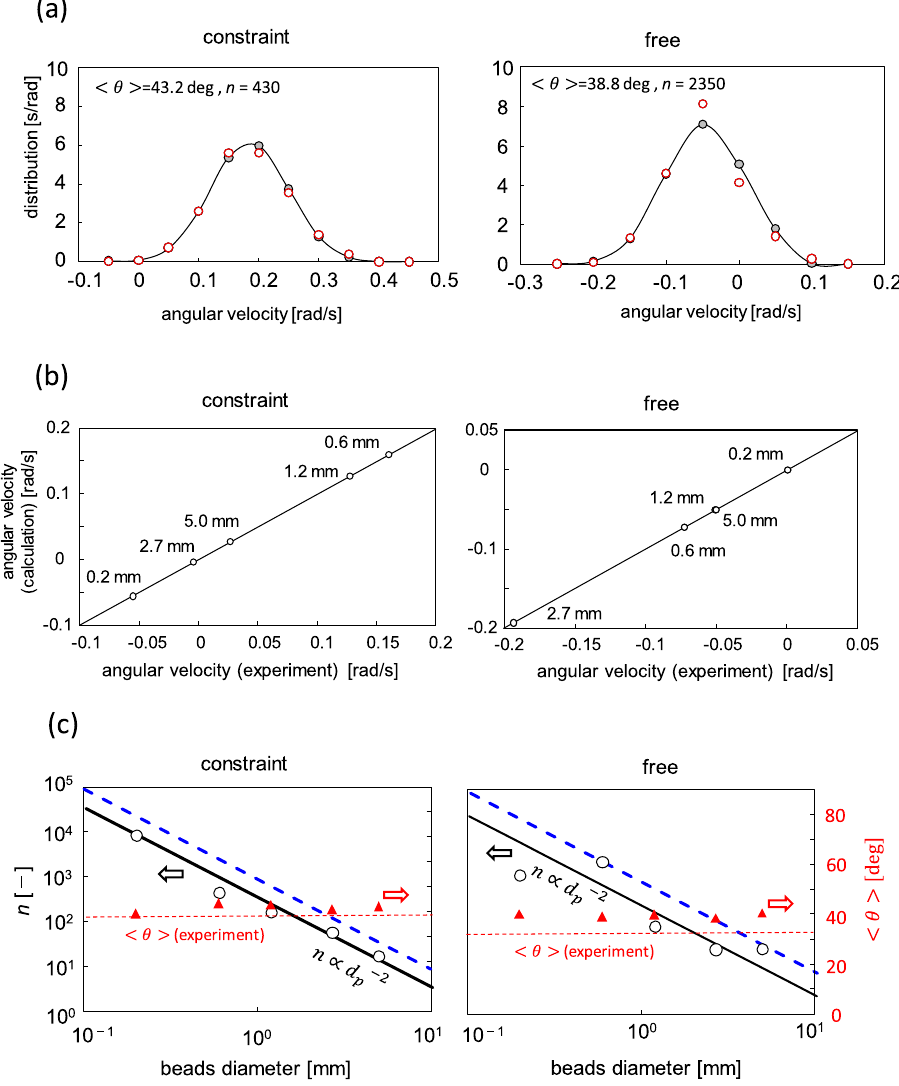
Figure 6. Calculation results. ( a ) Distribution of angular velocity for constraint and free conditions. Calculation result shown by filled circle with fitted curve. Experimental results with 0.6 mm diameter shown by open circle. ( b ) Average angular velocity obtained by calculation and experiment. In right panel, the keys of 1.2 and 5.0 mm are overlapped. ( c ) Values of adjustable parameters shown by triangle (< θ >) and circle ( n ). Dotted horizontal line shows experimental value of average collision angle; dashed line shows maximum value of n calculated using bead diameter and gear wall